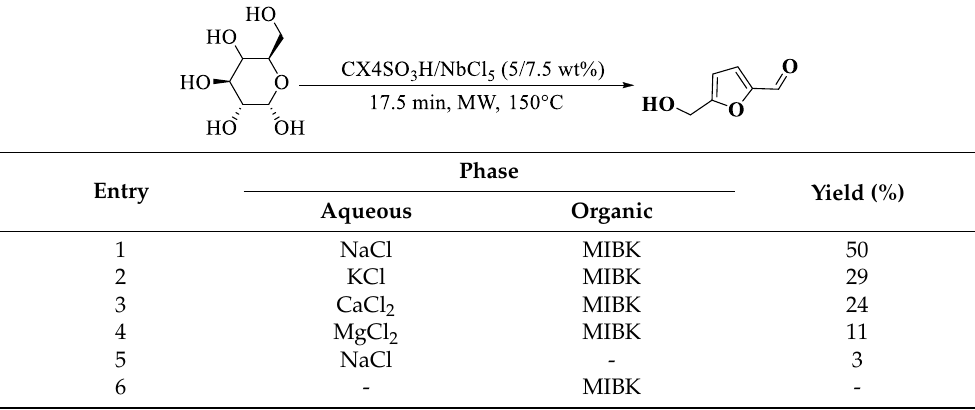
Table 3. Evaluation of the addition of different salt in biphasic system.